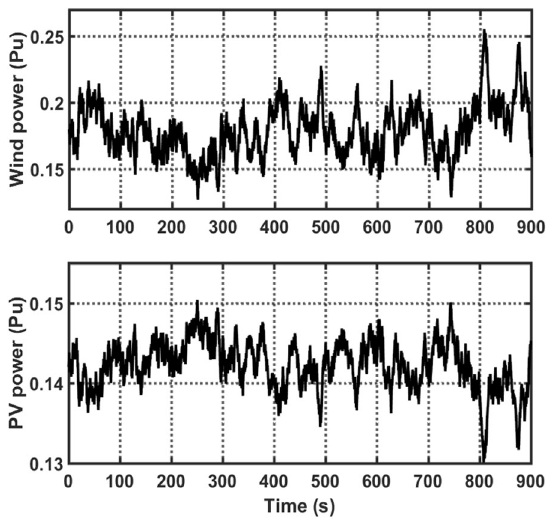
Fig. 8 Multiple disturbances in wind power and solar irradiation power